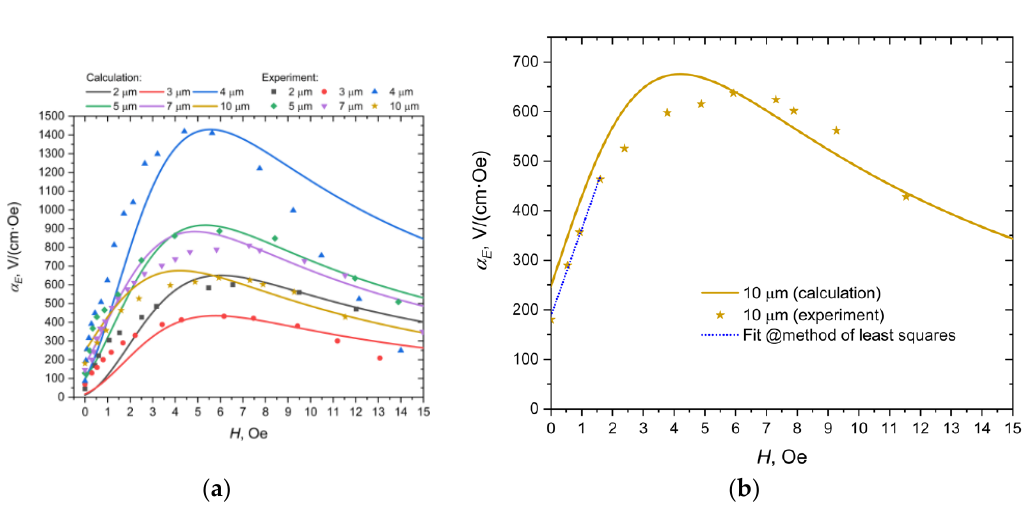
Figure 6. ( a ) Dependence of the resonance maximum of the ME voltage coefficient on the magnitude of the biased field for samples with different thicknesses of nickel. Individual points are experimental data, solid lines are theoretical dependencies. ( b ) Dependence of the resonance maximum of the ME voltage coefficient on the magnitude of the biased field for samples with thicknesses of nickel of 10 μm. Asterisks are experimental points and solid lines show the theoretical dependence. The dashed blue line is drawn through the first 4 experimental points using the least squares method.